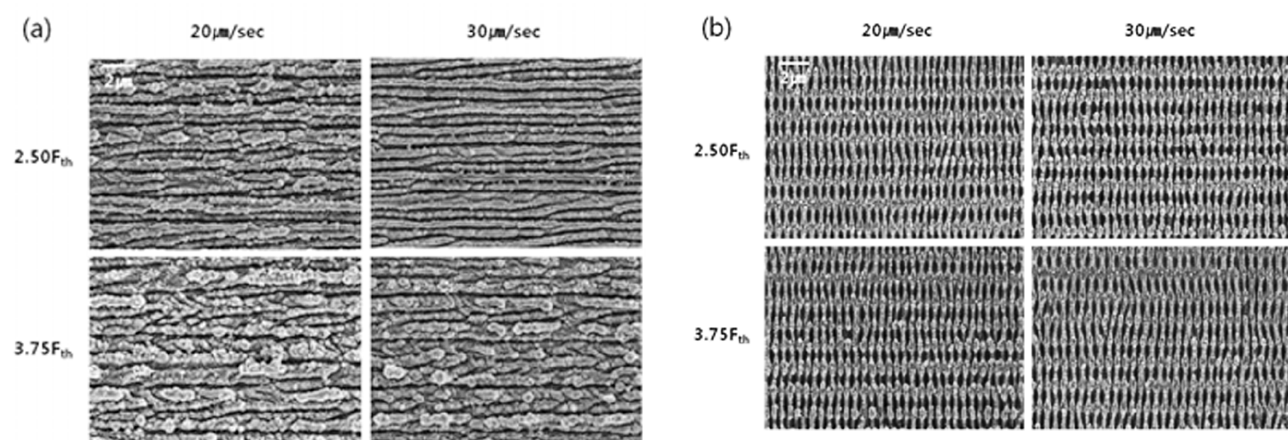
Figure 3. Nano- and microripples on X40Cr14. ( a ) Nanoscale ripples (NR); ( b ) microscale (MR) and nanoscale ripples (NR). “Reprinted with permission from Ref. [36], Copyright (2013), Elsevier”.